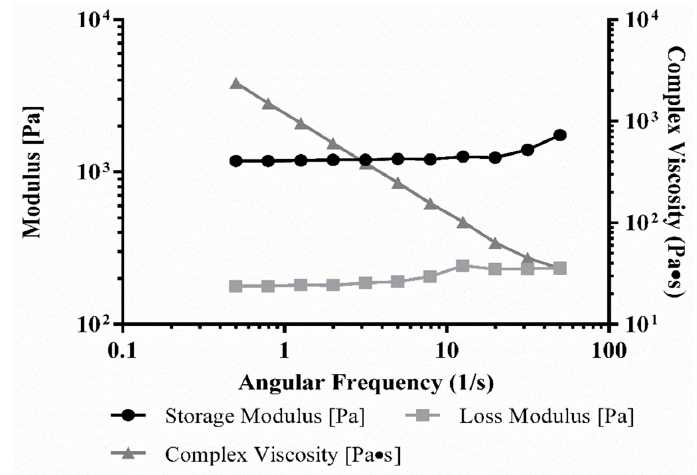
Figure 5. Rheology analysis of f-gelatin-based lattice structures, obtained from a disc-shaped (8 mm) sample.